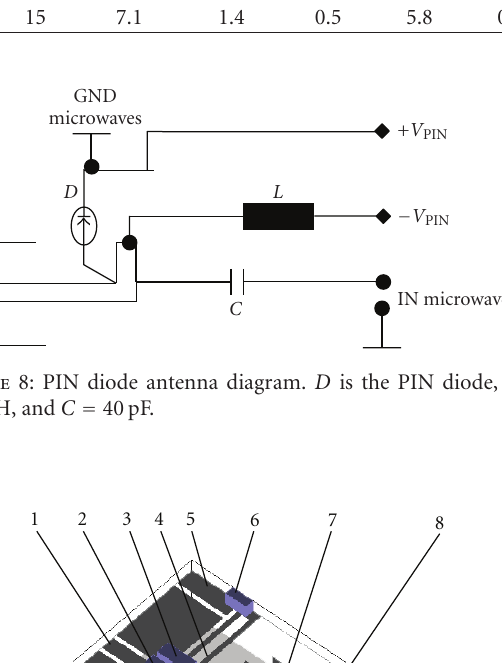
The input RF line (1) is DC decoupled (2) from